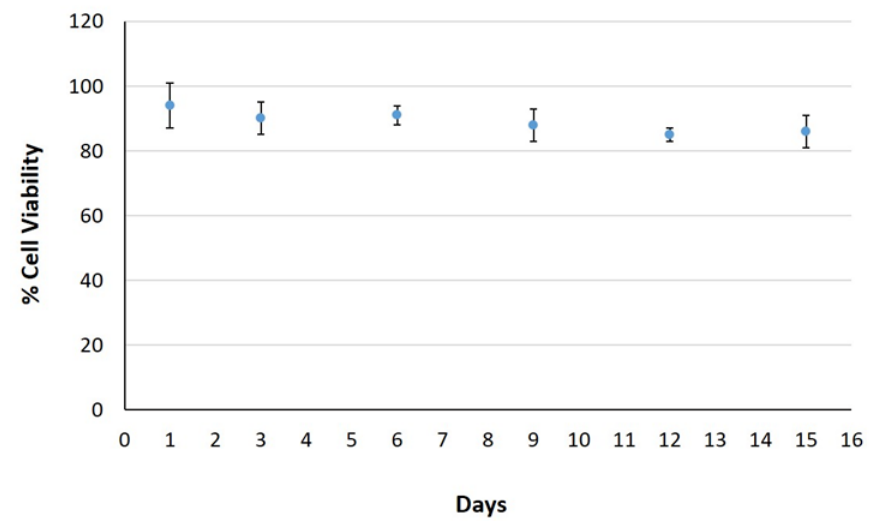
Figure 8. The graph depicts the percentage of cell viability during